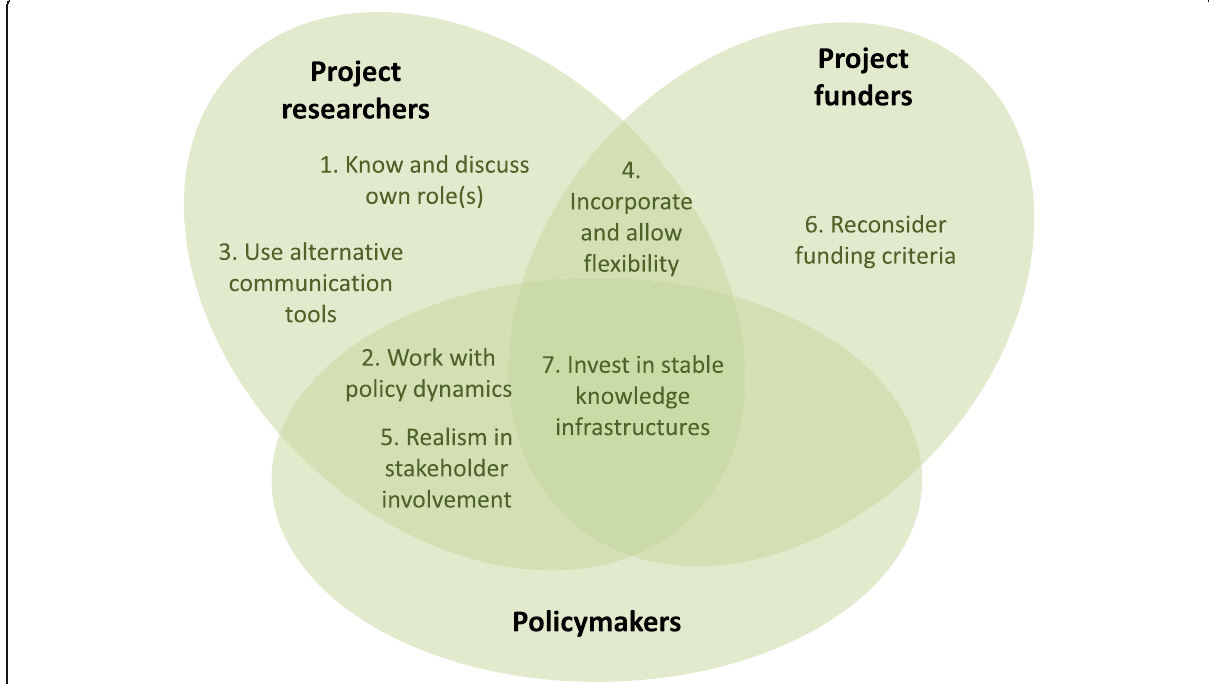
Fig. 1 Seven directions for strengthening the science-policy